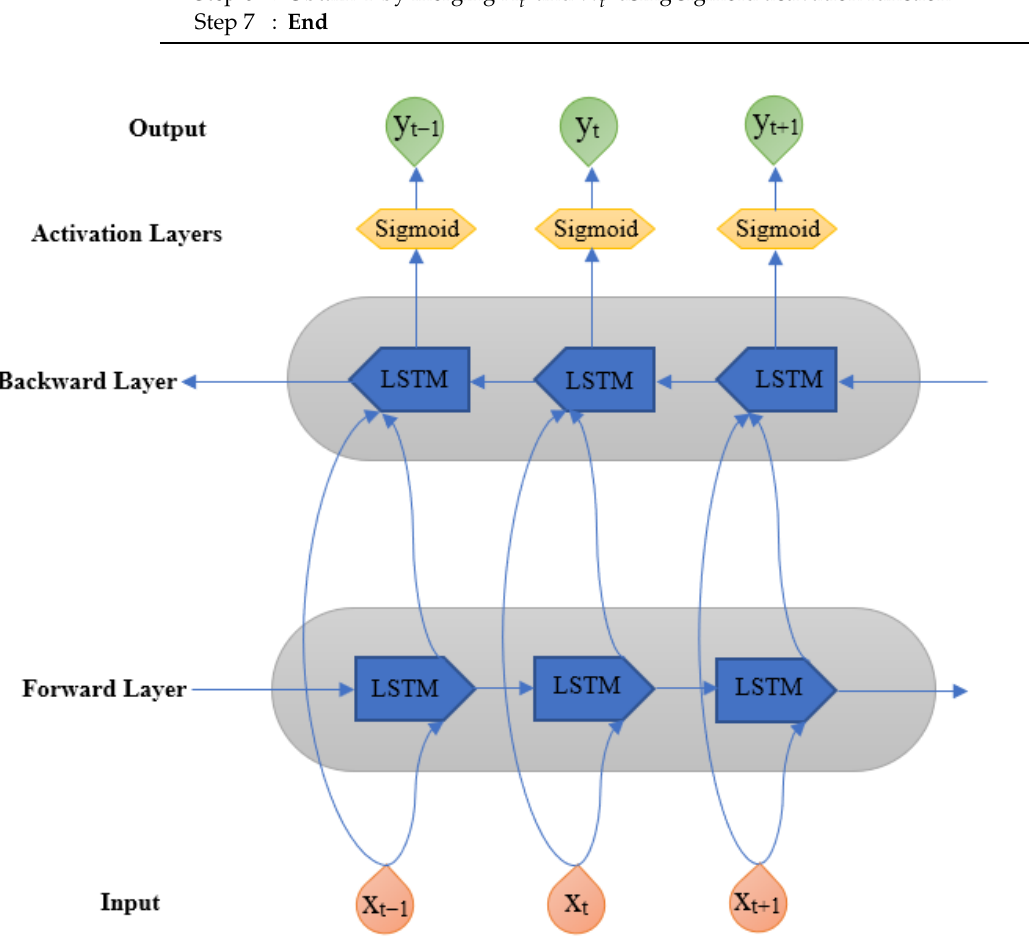
Algorithm 2: Bi-LSTM for phishing URL detection Input